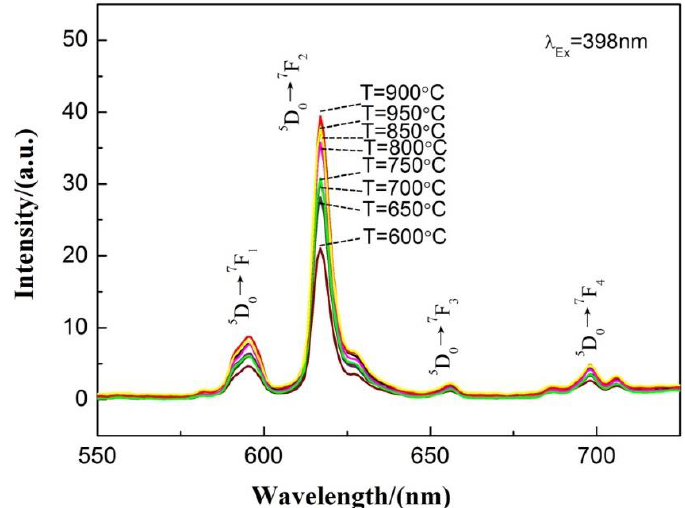
Figure 5. Emission spectra under an excitation wavelength of 398 nm of the Ca 0.97 TiO 3 :Eu 3+0.03 prepared at different traditional sintering temperature.